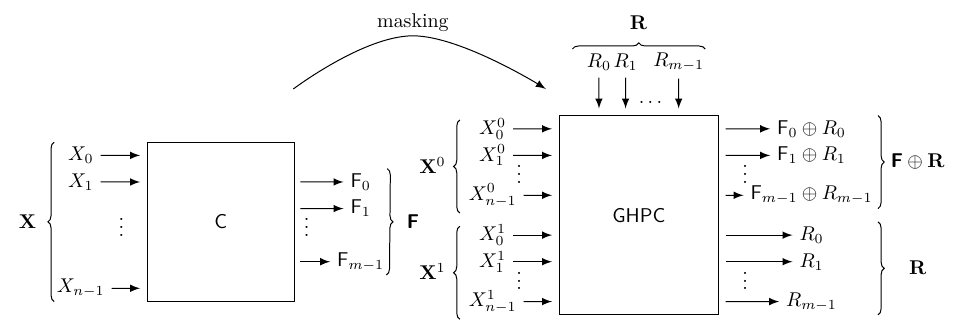
Figure 1: An overview of first-order